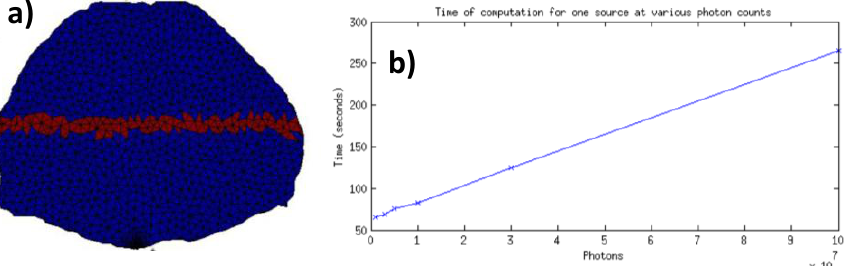
Figure 9. ( a ) Elements of volume employed to compute the error 𝑒(𝑟) (red label); ( b ) Computation time for one forward simulation versus number of photons.